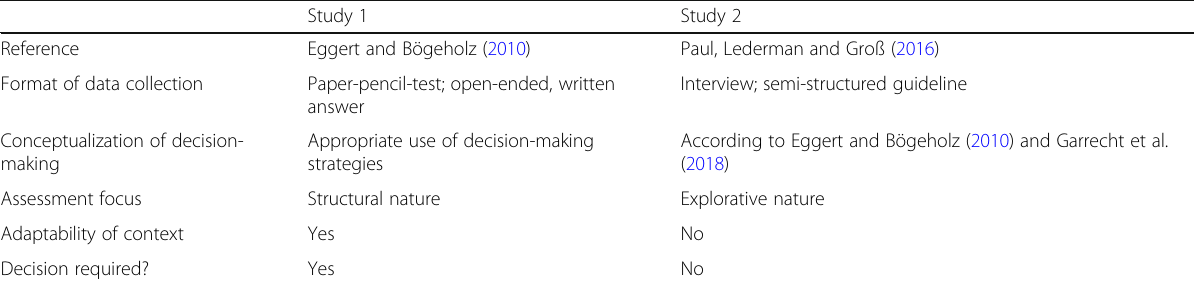
Table 5 Characteristics of the instruments as they have been used within the two